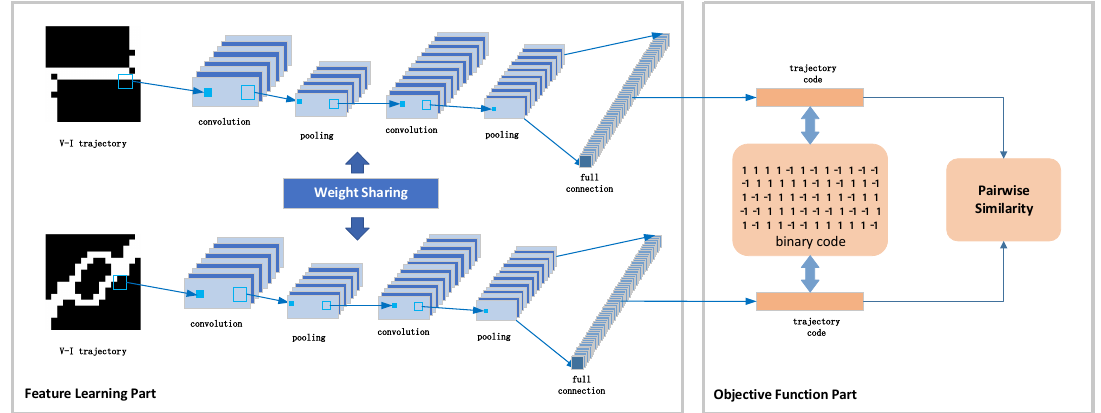
Figure 2. The end-to-end deep learning architecture of the proposed